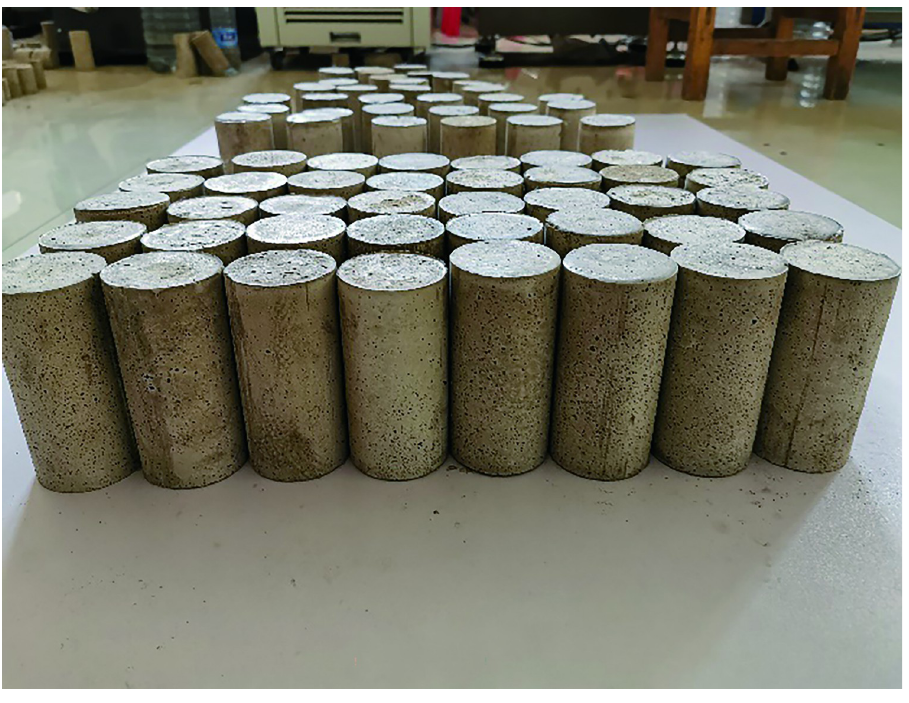
Fig 11. Rockburst-like materials specimens.